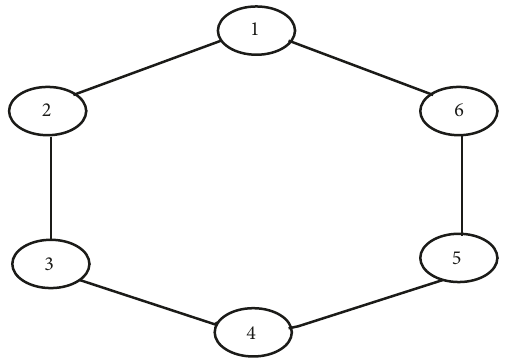
Figure 1: The communication topology for the distributed